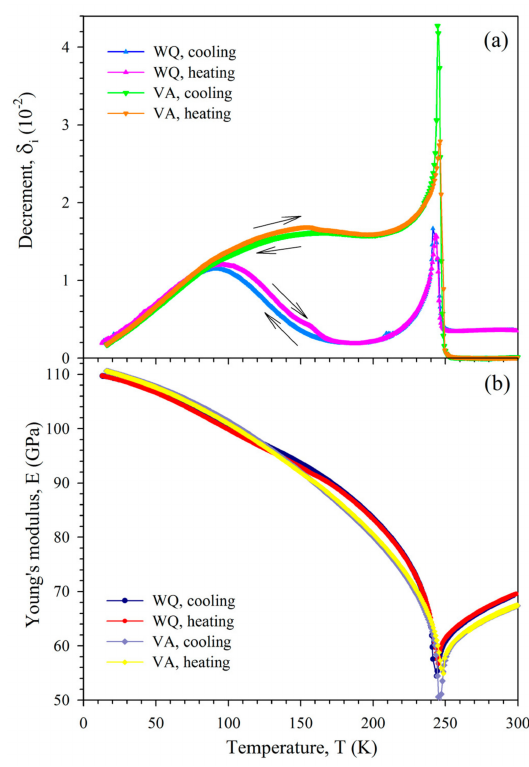
Figure 2. Temperature dependence of the decrement ( a ) and effective Young’s modulus ( b ) of the Ti 50 Ni 46.1 Fe 3.9 sample measured in a cooling-heating cycle at strain amplitude of 10 –6 after water quenching (WQ) or vacuum annealing (VA).